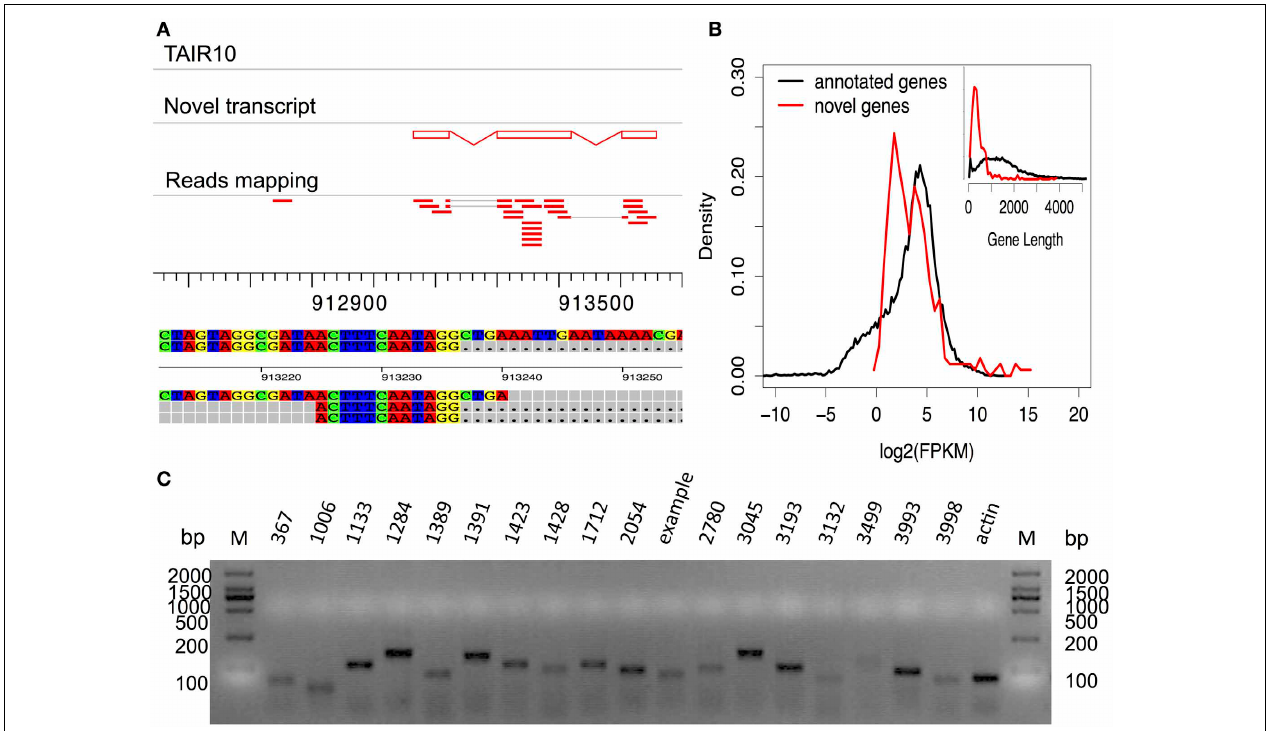
FIGURE 5 | Analysis of novel identified transcripts. (A) Display of a novel transcribed region identified by RNA-Seq analysis. It includes three exons, supported by short reads (in red bars). Detailed alignment information (first exon-intron junction) is given in the lower